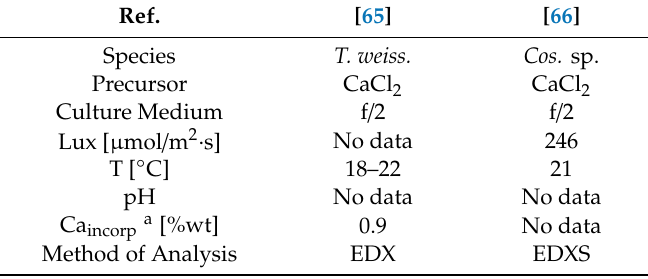
Table 4. Summary of parameters for doping of diatomaceous biosilica with calcium ions. Ref.